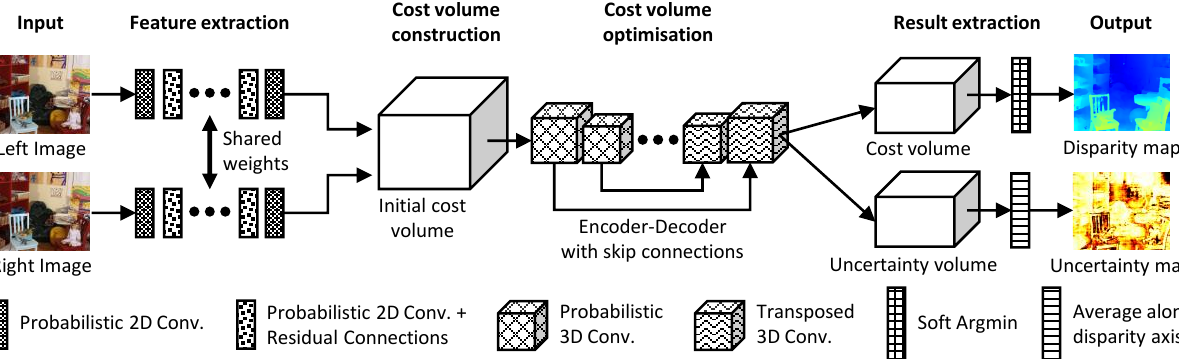
Figure 2: Probabilistic GC-Net architecture. Based on the GC-Net architecture (Kendall et al., 2017), the 2D and 3D convolutional layers have been adapted to sample the corresponding parameters from a probability distribution instead of learning them